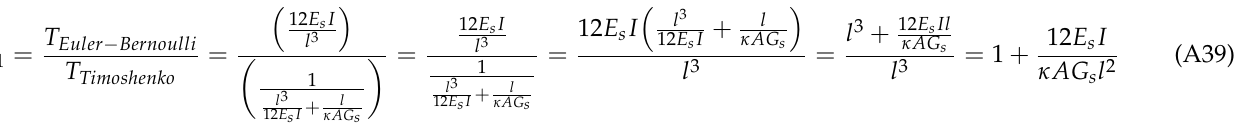
Figure A5. Combined stress of unit cells: ( a ) BCC; ( b ) diamond; ( c ) hexagonal packing; ( d ) rhombicuboctahedron; ( e ) truncated cube, and ( f ) truncated octahedron in ANSYS.